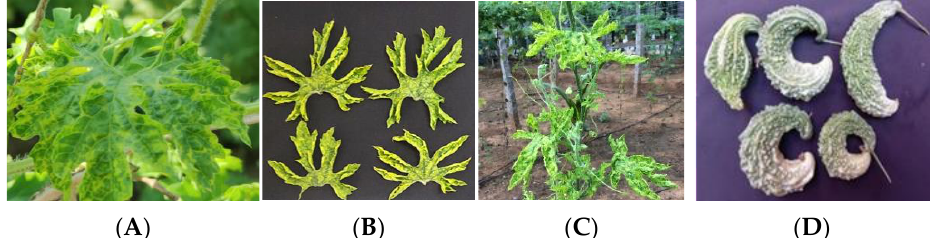
Figure 2. ( A ) Severe mosaic—BgYMV alone ( B ) Severe Mosaic and upward rolling—ToLCNDV alone ( C ) Mild mosaic and upward curling—ToLCNDV and BgYMV ( D ) Malformed fruits from plant with both